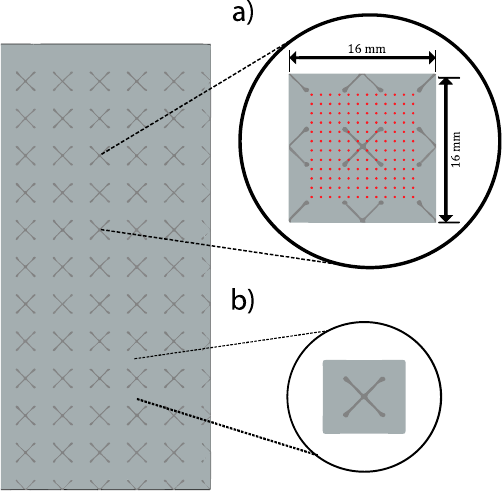
Figure 4. Analysis zone of the ( a ) hardness mapping, ( b ) SEM scan. The mapping was carried out with a load of 100 g and a holding time of 10 s. The test was performed for the initial condition, one, two, and four-cycles, with an average of 256 indentations for the processed and 36 for the initial condition samples.